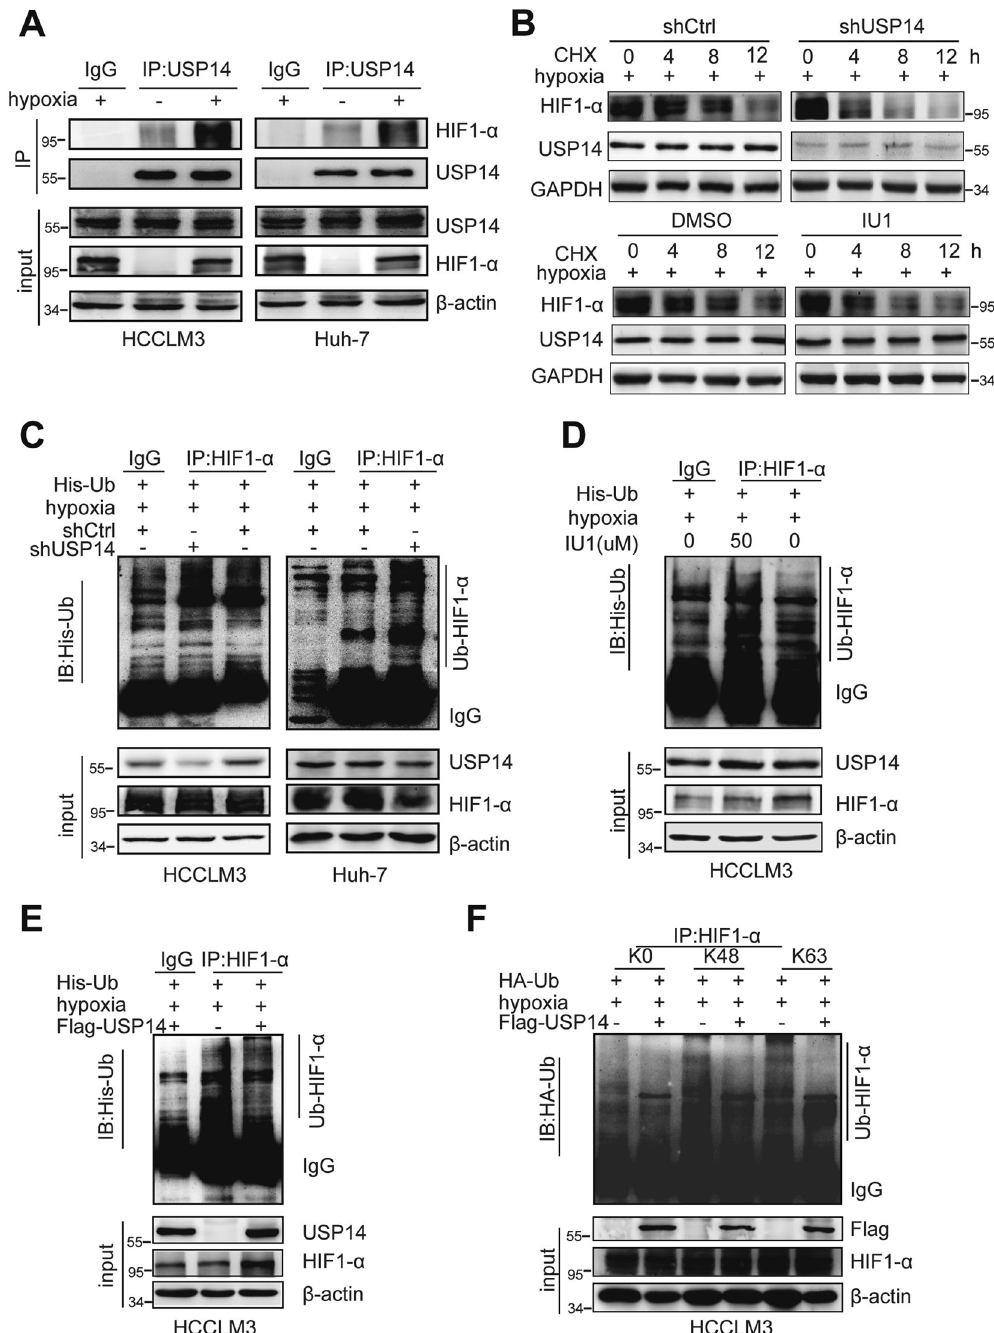
Fig. 3 USP14 interacts with HIF1- α and participates in deubiquitination of HIF1- α . A Immunoprecipitation experiments showed that endogenous USP14 interacted with HIF1- α in both HCCLM3 and Huh-7 cells. Cells were treated with or without CoCl2 (100 mM). B HCCLM3 cells stably knocking down of USP14 or IU1 addition were treated with cycloheximide (CHX) as indicated. Western blot was used to detect HIF1- α and USP14 protein levels. C The control and USP14 knockdown HCCLM3 and Huh-7 cells were treated with MG132 at 20 μ M for 6 h. The cell lysates were then immunoprecipitated with anti-HIF1- α , and the immunocomplexes were immunoblotted with anti-His. D Protein lysates were collected from HCCLM3 cells treated with IU1 for 48 h. A co-immunoprecipitation assay was performed using HIF1- α antibody and immunoblotted with anti-His. Cells were exposed to MG132 (20 μ M) for 6 h before harvest. E HCCLM3 cells were transfected with Flag-USP14 or empty vector and followed by immunoprecipitation with anti-HIF1- α . F HCCLM3 cells with ectopic expression of Flag-USP14 and HA- tagged different ubiquitin mutants, including K0 (lysineless), K48 (only K48-linked-Ub), and K63 (only K63-linked-Ub) were treated with MG132 (20 μ M) for 6 h as indicated. The cell lysates were immunoprecipitated by using anti-HIF1- α . The ubiquitination levels of HIF1- α were detected using anti-HA. All the above hypoxic environment refers to hypoxia-induced by CoCl2 at 100 μ M.